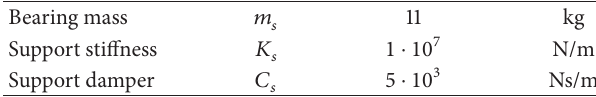
Table 4: The properties of the supporting structure. Bearing mass